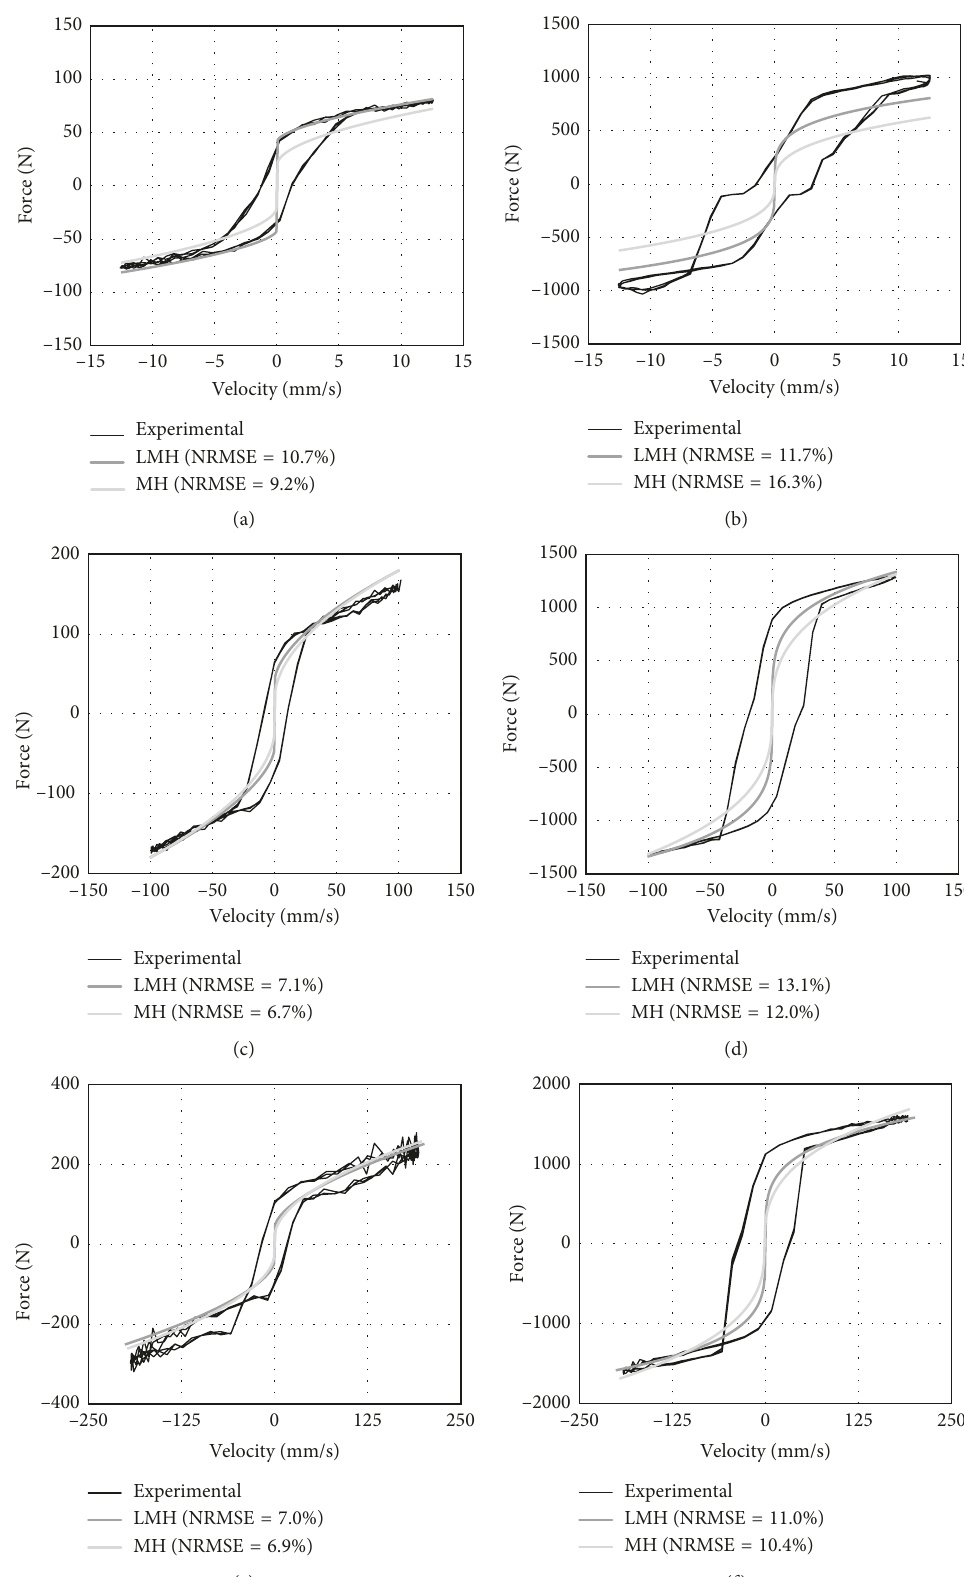
Figure 8: Herschel–Bulkley model (fitted with LMH and MH tests) predictions for six different tests: (a) low velocity without intensity; (b) low velocity with I 1A; (c) medium velocity without intensity; (d) medium velocity with I (cid:31) high velocity with I (cid:31)